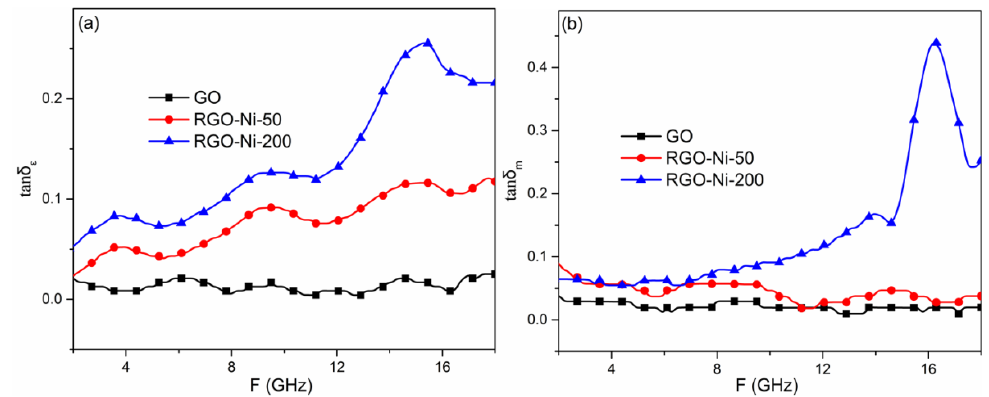
Figure 4. The corresponding dielectric loss tangents ( a ) and magnetic loss tangents ( b ) of GO, RGO–Ni-50, and RGO–Ni-200.